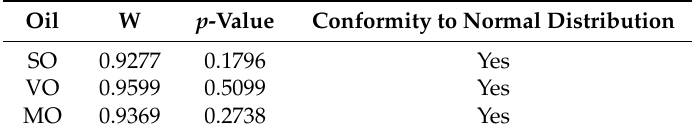
Table 5. Hypothesis test of conformity to normal distribution of oils alone in DC.